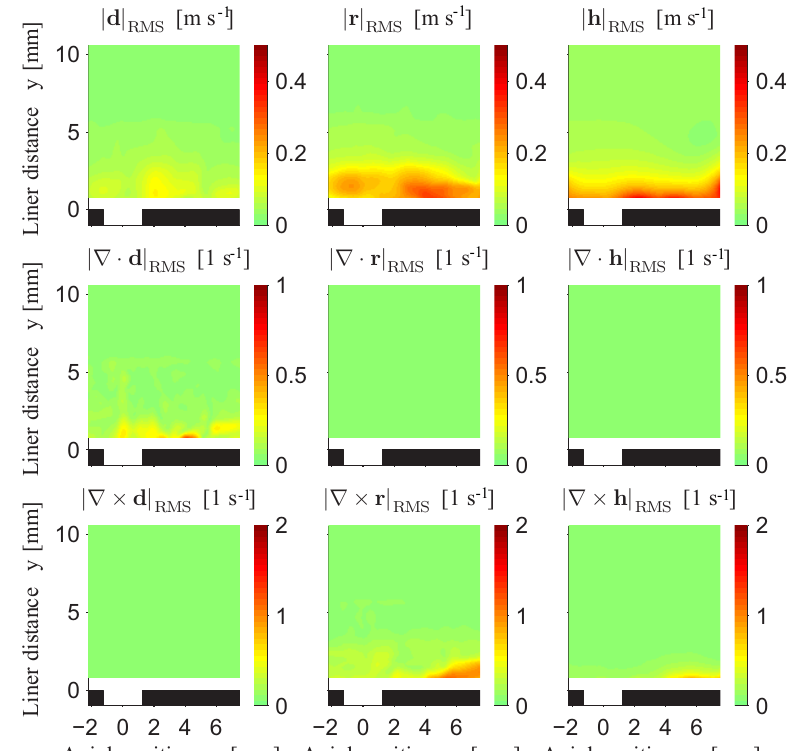
Figure 7. Root mean square (rms) of the output vector fields ( l 2 norm) from Fig. 6 at the lateral position z = 0 using all phase values ϕ regarding the acoustic excitation